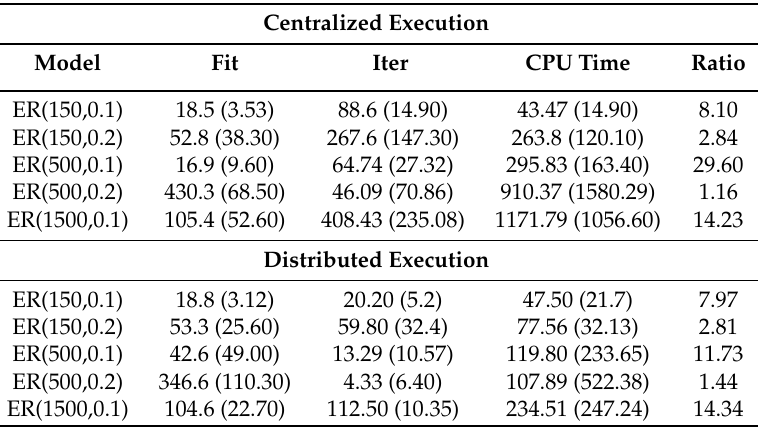
Table 3. Models (Erdos–Renyi), best fitness (Fit), iteration (Iter), CPU Av. time., the ratio between input and output vertices. The standard deviation is shown in